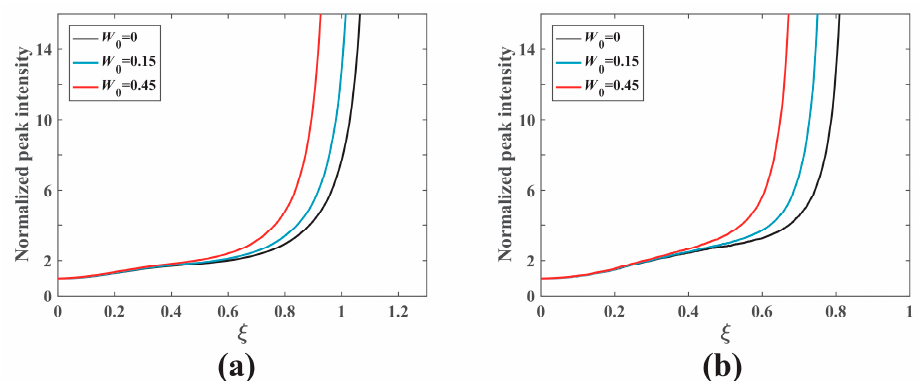
Figure 5. The normalized peak intensity of vortex beams with V 0 = 1 and P in = 1.4 P cr as a function of the propagation distance for different modulation depths of gain–loss W 0 in the Kerr–SCPT and Kerr–ROLP media ( W 0 = 0). The plots ( a ) and ( b ) correspond to n = 1 and 2, respectively.